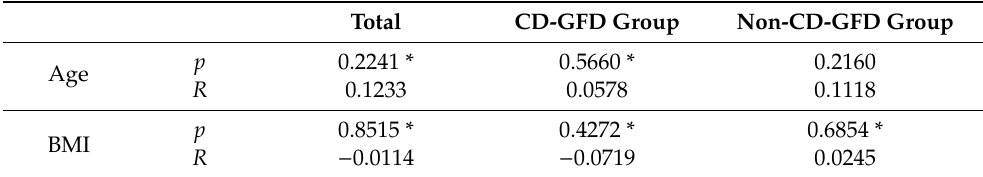
Table 4. The results of correlation analysis between Food Neophobia Scale (FNS) scores and age, as well as BMI, in the sub-groups of CD-GFD and non-CD-GFD individuals.